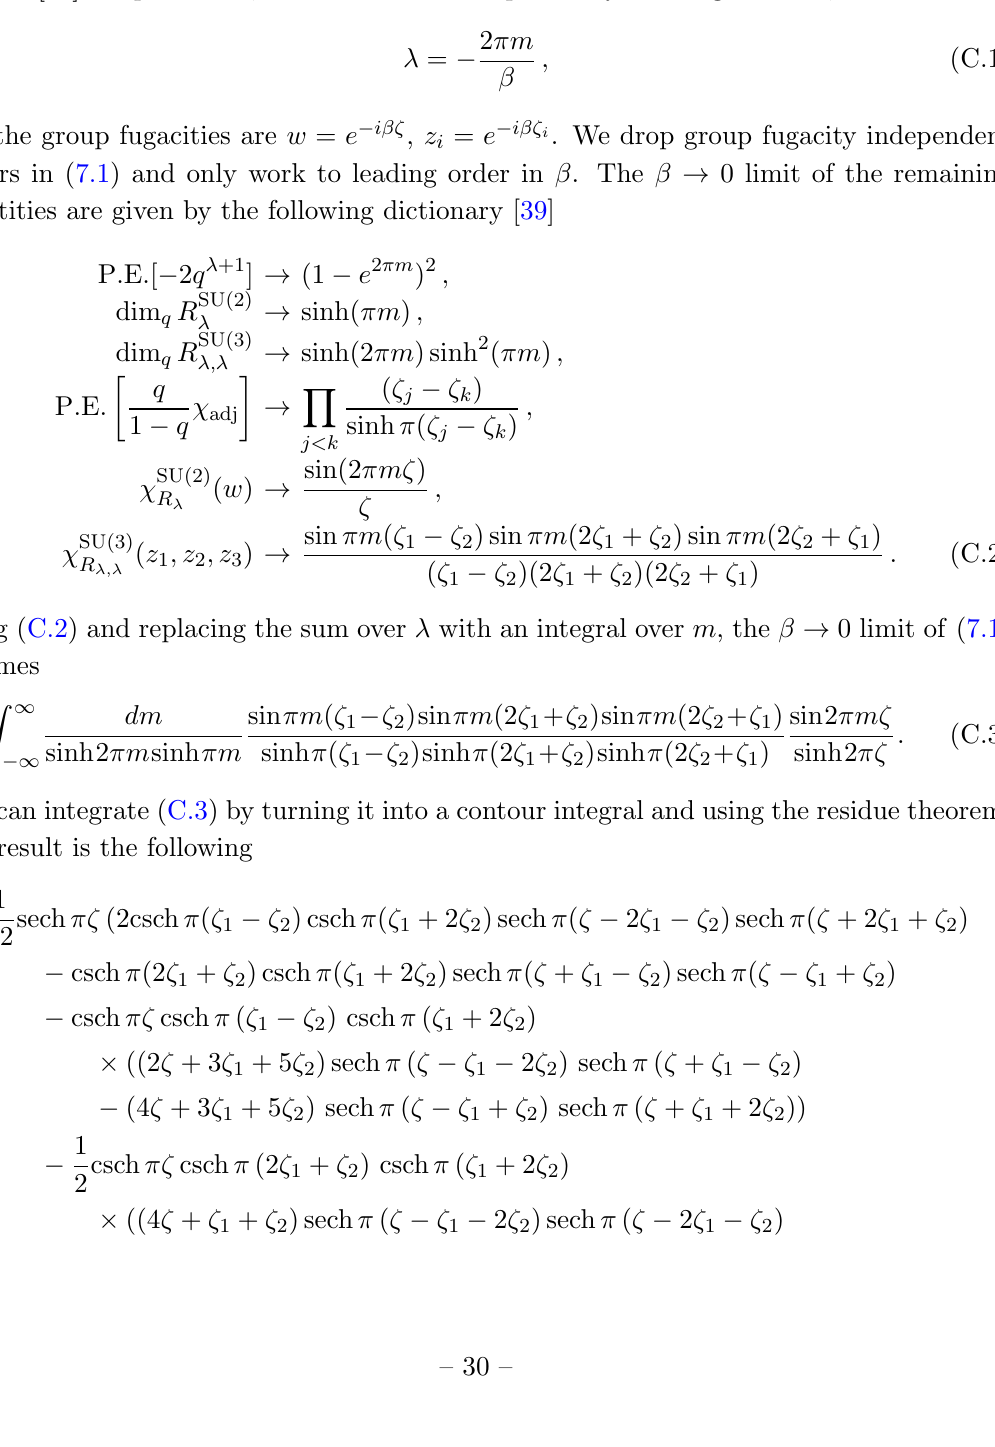
Figure 6 . The quiver diagram describing the S 1 reduction of the mirror in figure 3). The closed loop beginning and ending at the U(2) node denotes an adjoint hypermultiplet of